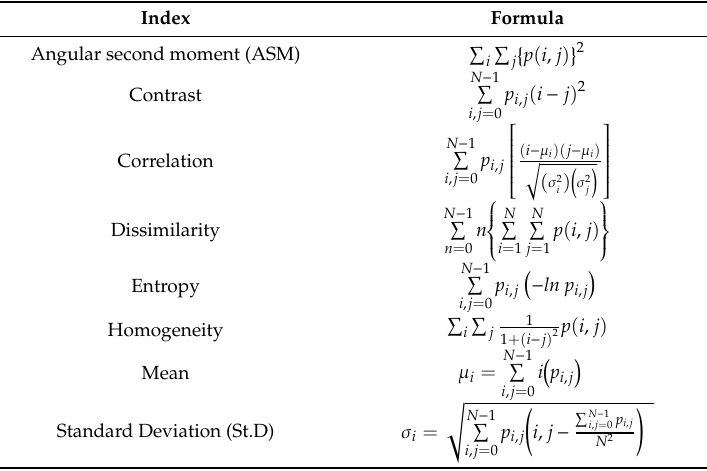
Table 4. Gray level co-occurance matrix (GLCM)-based textural